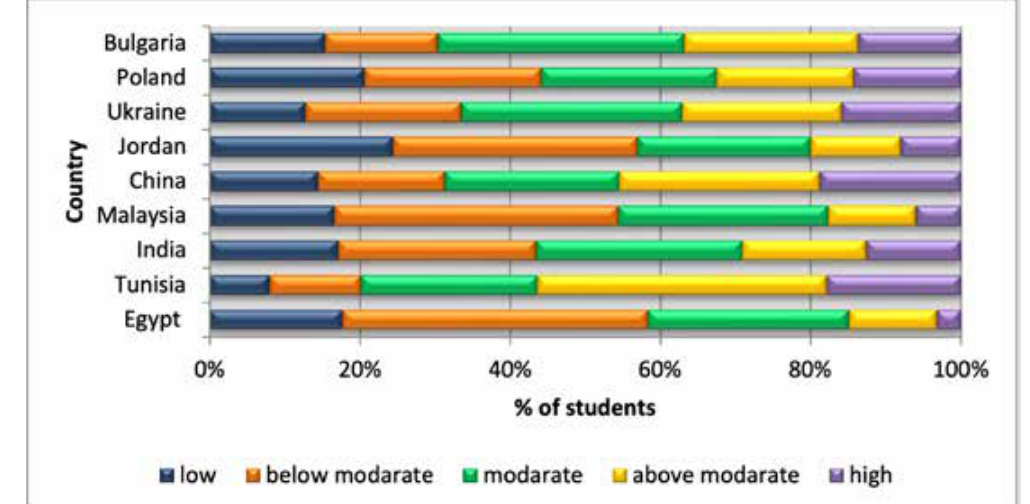
Figure 4. Distribution by levels of speed readiness of students